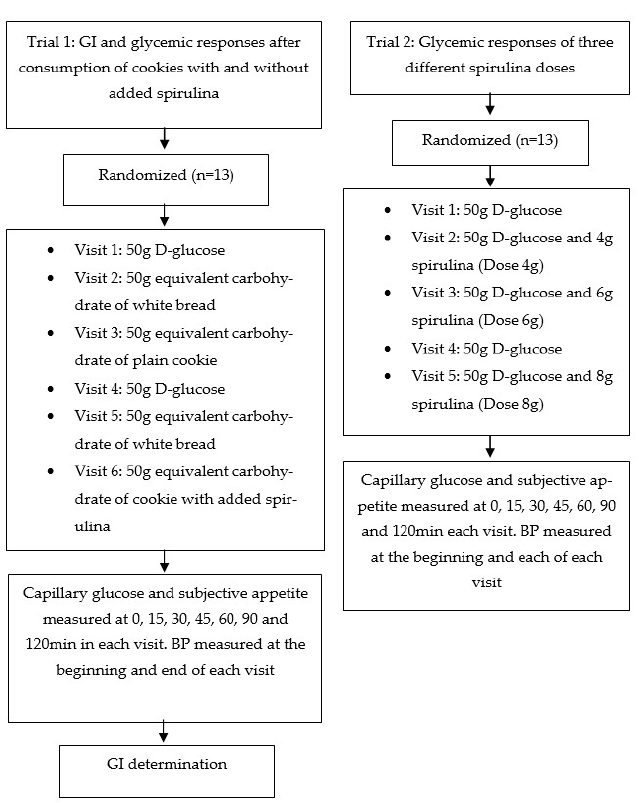
Figure 1. Flowchart of the two current investigations given as examples of the crossover, random- ized procedure. Eligible participants were studied in separate days over a period of 3–9 weeks with an interval of no less than 40 h and more than 2 weeks between tests. Participants attended the sessions of around 3 h duration, separated by a wash-out period of at least two days. Abbreviations: GI = glycemic index; BP = blood pressure.